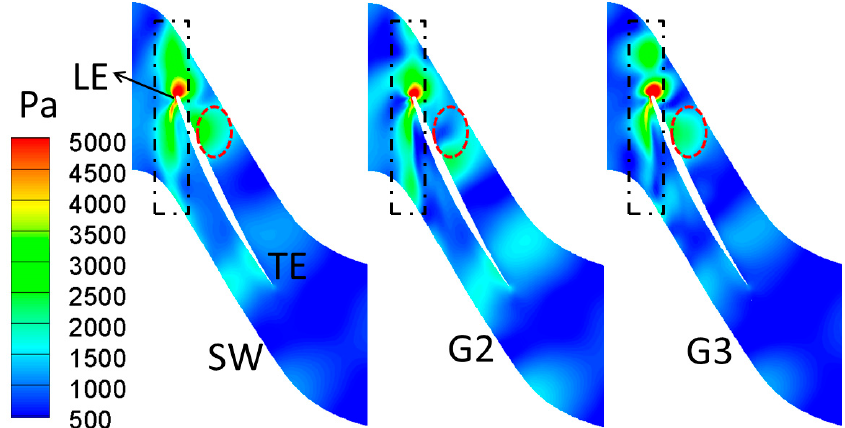
Figure 16. STD static pressure contours at 99% blade span of R2 in different CTs.